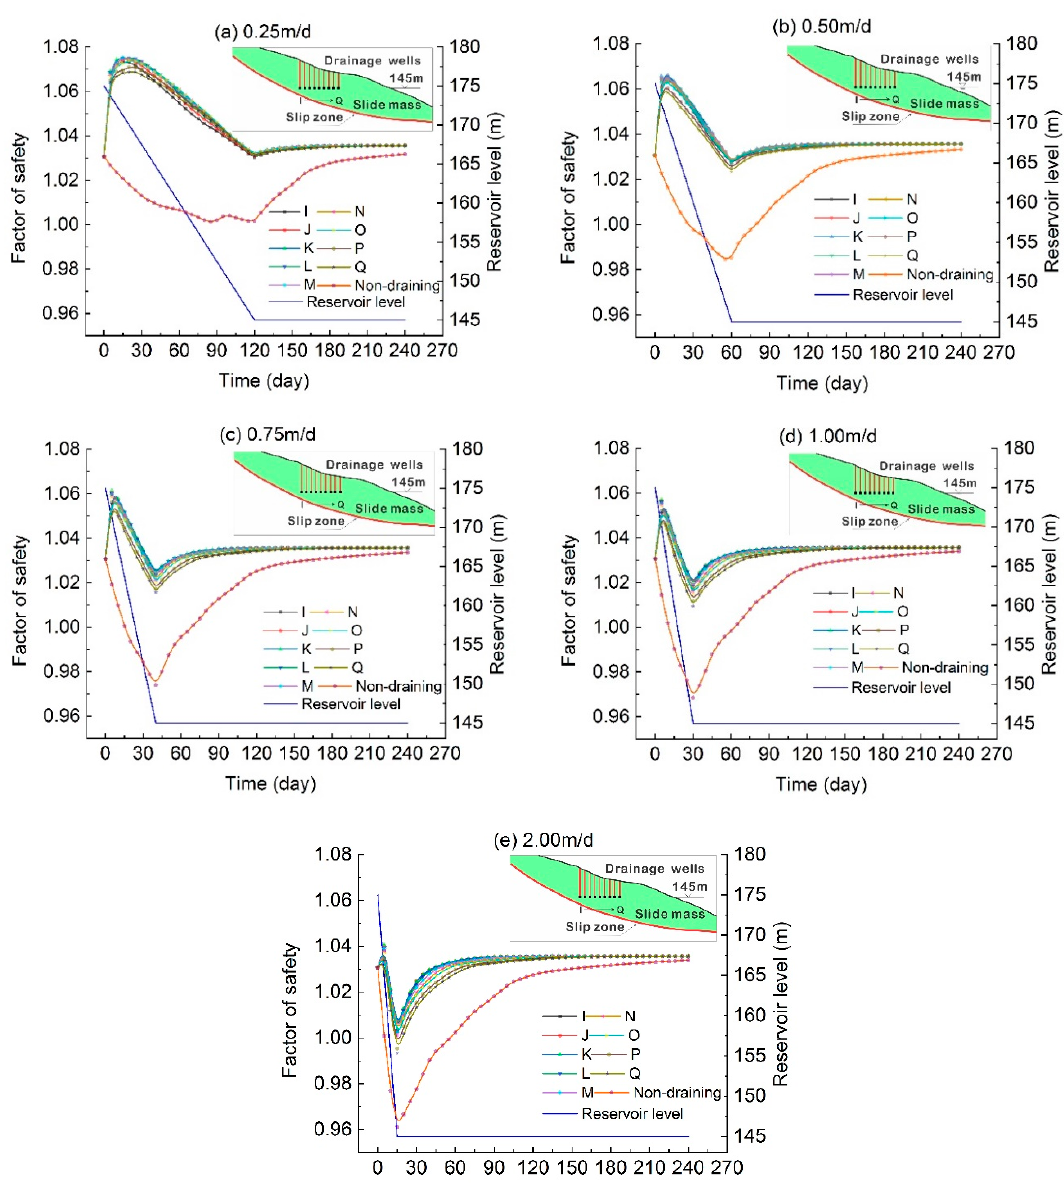
Figure 12. Variation of the landslide stability under different drawdown rates of the reservoir, with ( a – e ) refer to the condition with rate of 0.25 m/d, 0.50 m/d, 0.75 m/d, 1.00 m/d and 2.00 m/d,